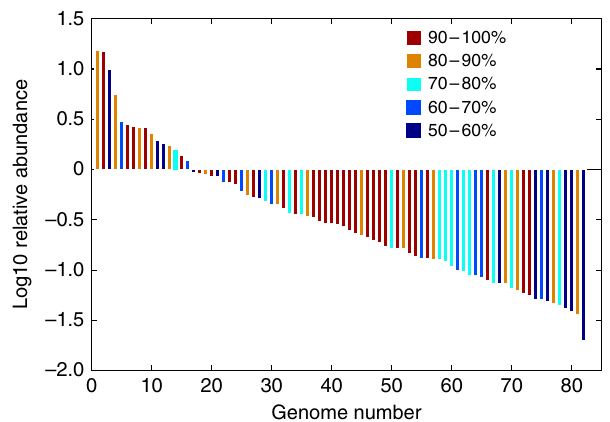
Fig. 2 Rank-abundance plot of SJ3 reconstructed population level bins. Each vertical bar represents a reconstructed genome bin that has an estimated completeness > 50% ( n = 82). Genome bins are arranged by log 10 transformed relative abundance (as a percentage) in decreasing order, as determined by read mapping. The scale on the upper right corresponds to the estimated percent completeness of each genome